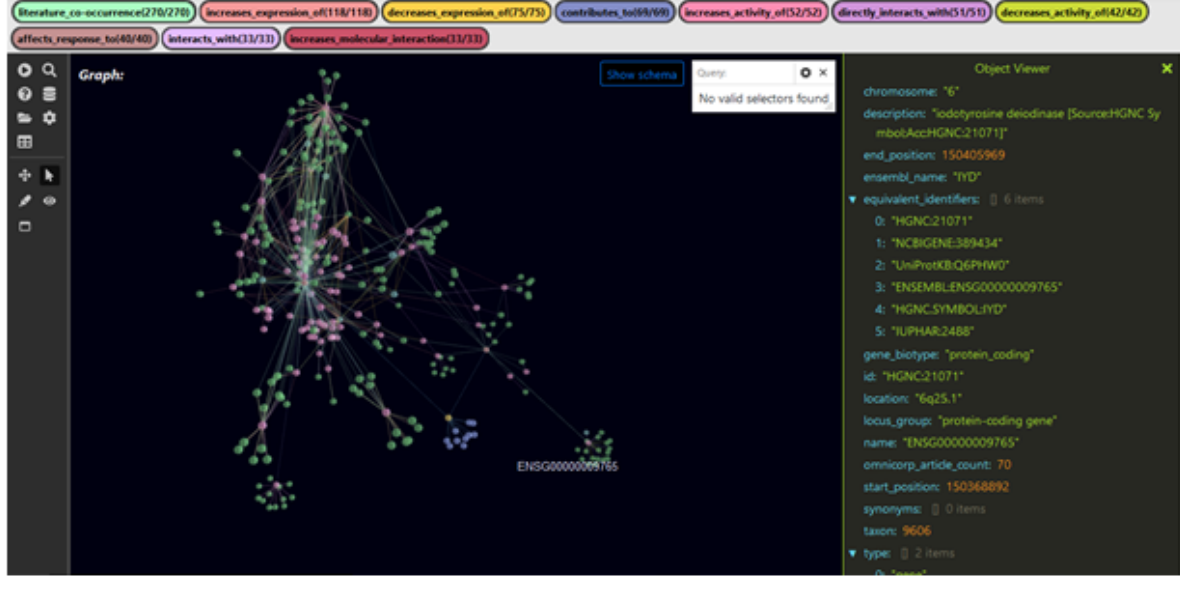
Figure 7. Metadata associated with the gene IYD (iodotyrosine deiodinase), which are found in the answer KG for the TranQL query shown in